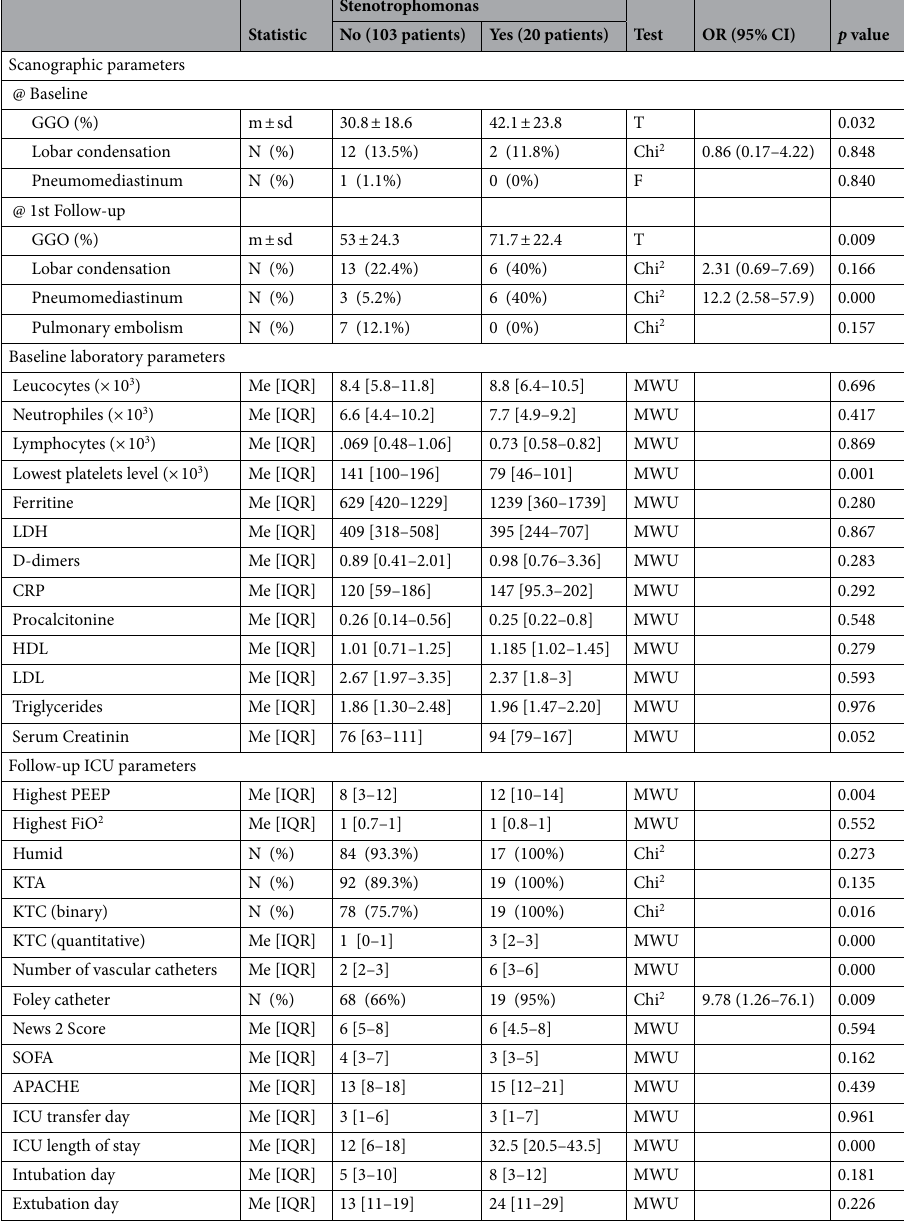
Table 1. Scanographic, baseline laboratory and ICU parameters in the 2 groups without and with Stenotrophomonas infection. Categorical data are presented as frequencies and percentages (N (%)); Continuous data not departing from normality assumptions are presented as mean and standard deviation (m ± sd). Continuous data departing from normality assumptions and ordinal data are presented as Median with its interquartile range (1st quartile–3rd quartile) (Me [IQR]). Chi 2 : Chi square test; MWU: Mann– Whitney U test. For binary data, the odds ratio with its 95% confidence interval were calculated [OR (95% CI)]. F: Fisher exact test. T: independent samples T